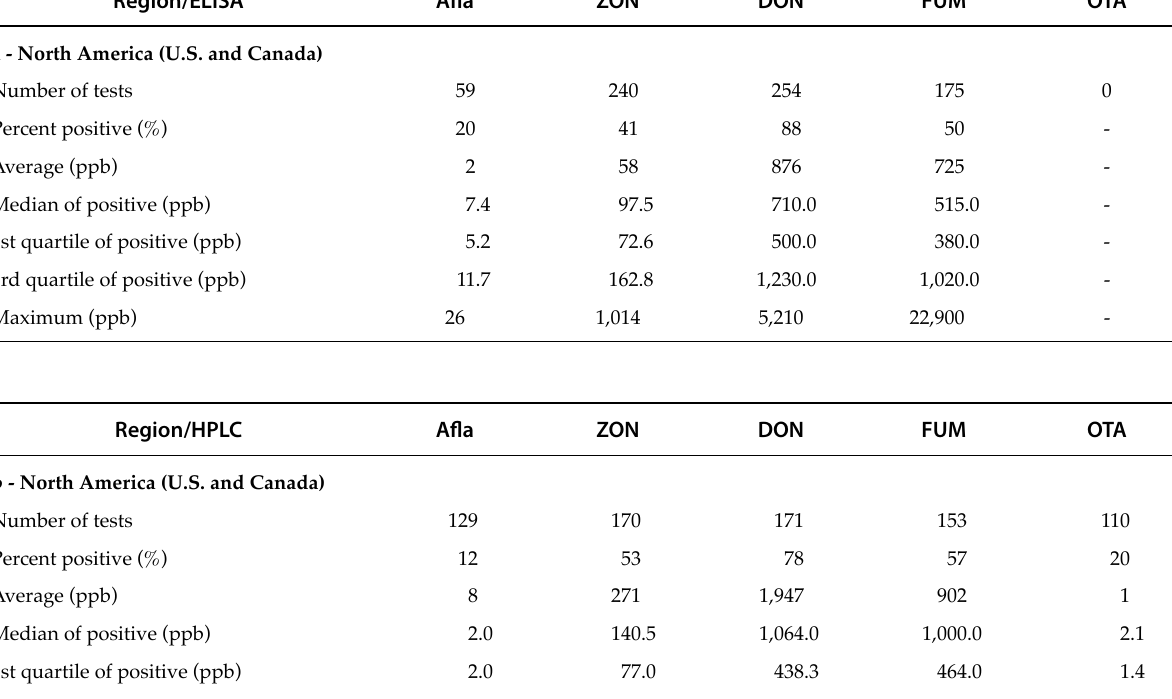
Table 5. Survey results by geographic region (North and South America region, ELISA and HPLC). Region/ELISA Afla ZON DON FUM OTA a - North America (U.S. and